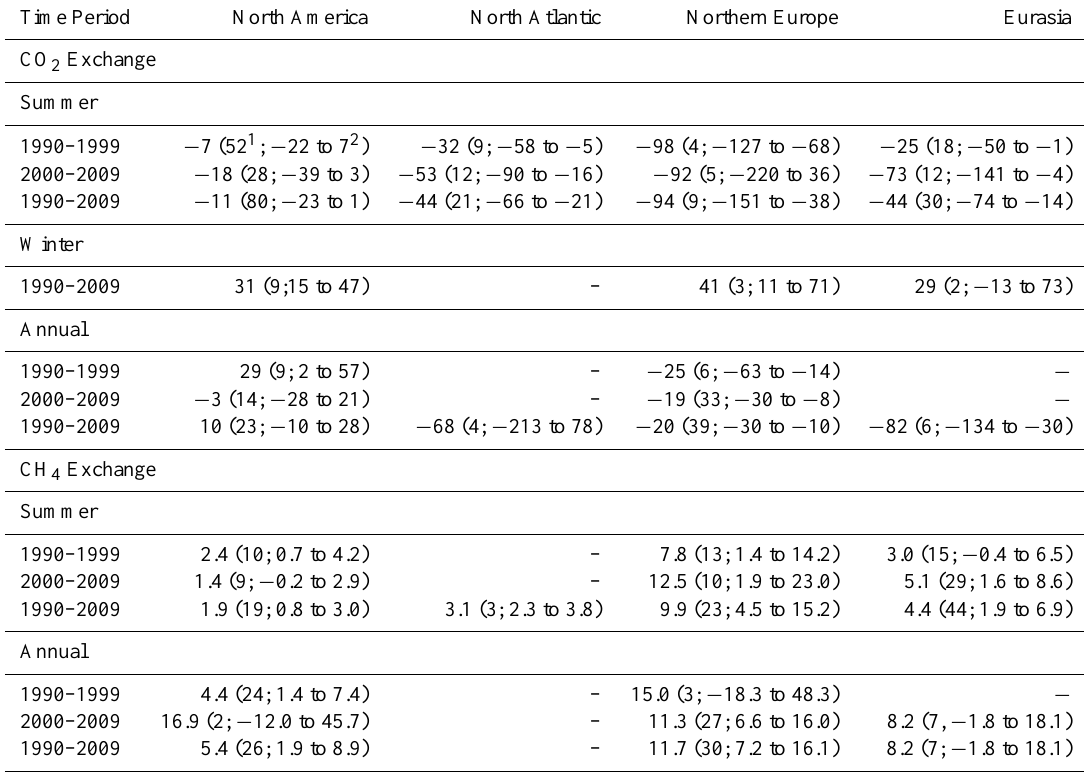
Table 3. Summary of observationally based estimates of mean net CO 2 -C and CH 4 -C exchange from Arctic tundra to the atmosphere (gCm − 2 season − 1 ) for different subregions.